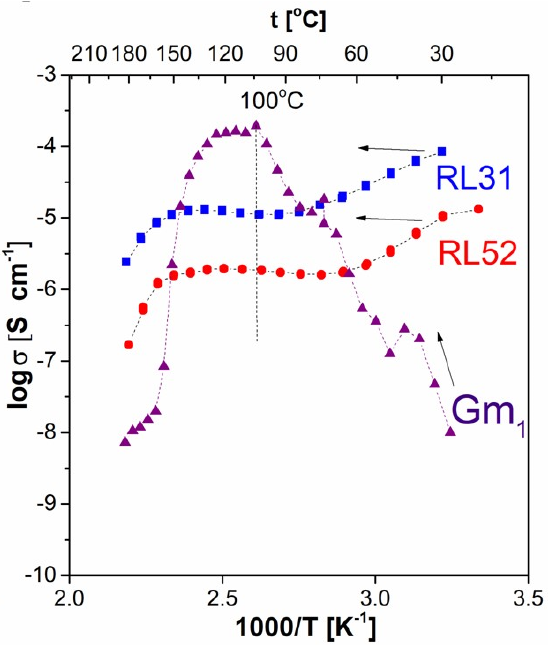
Figure 5. Comparison of the temperature dependencies of bulk ionic conductivity of two specimens (RL31, RL52), of monolithic PSG-30P 2 O 5 –70SiO 2 and Gm-pelletized pulverized material of the same composition.